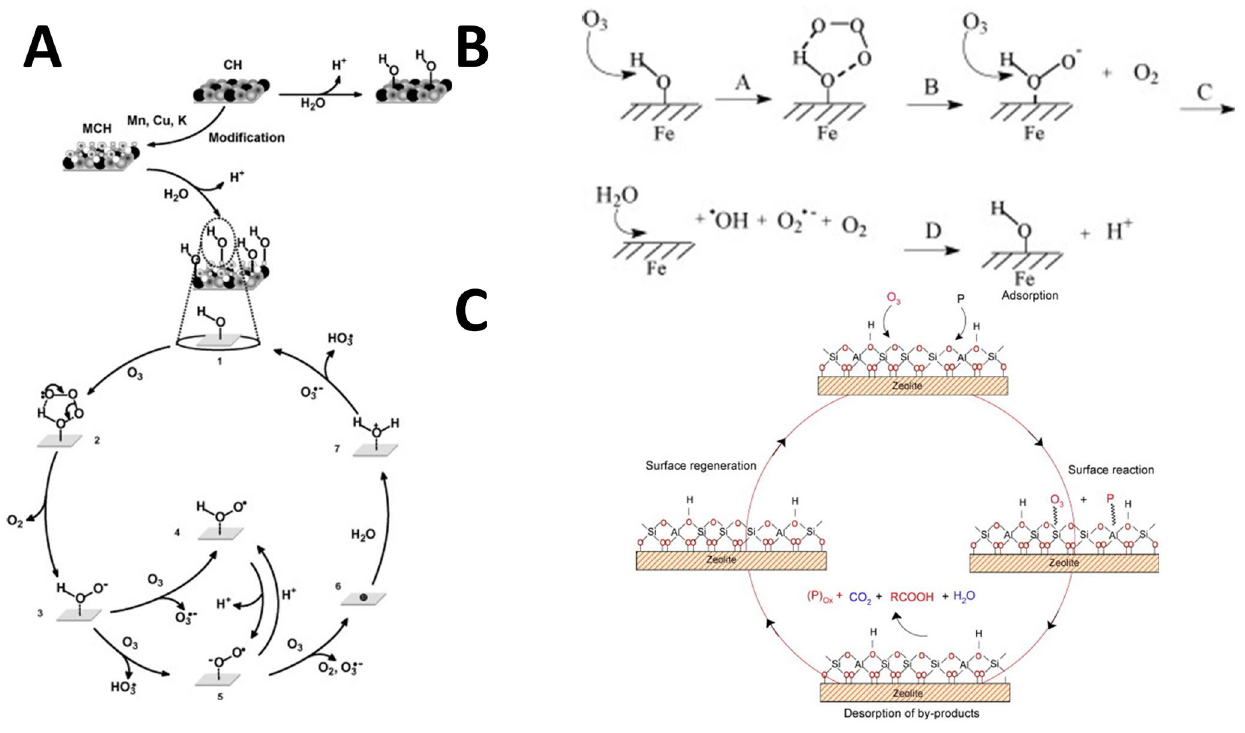
Figure 8. Scheme of mechanism proposed in the process of catalytic ozonation. ( A ) zonation of organic matter by honeycomb ceramics; ( B ) hydroxyl radical generation when aqueous ozone interacts with surface hydroxyl group of FeOOH in water; ( C ) catalytic ozonation on ZSM-5 zeolites. Reproduced with permission from Ref. [109,115,116].